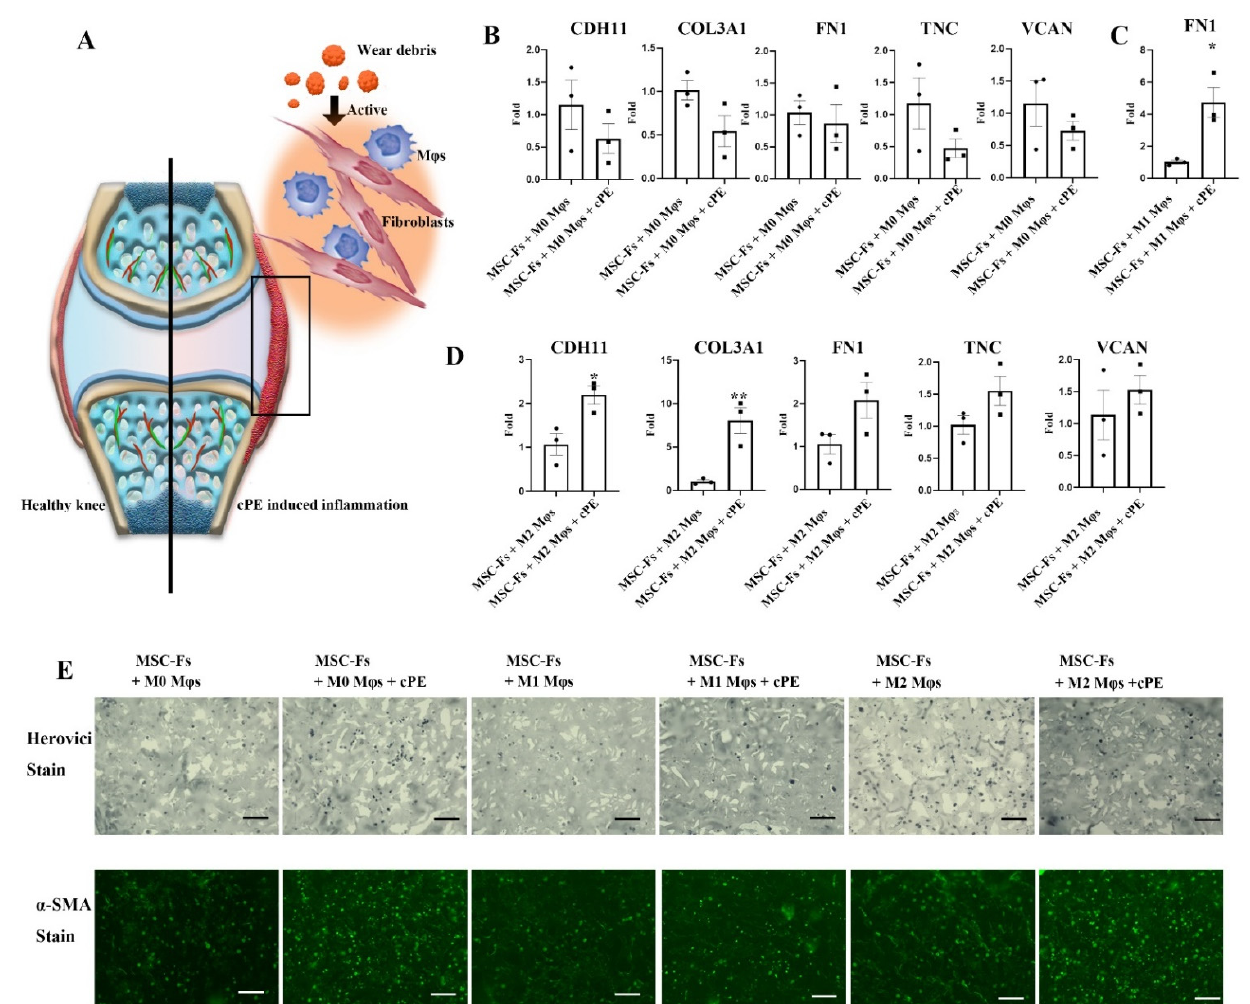
Figure 2. The effect of M ϕ s on the modulation of fibroblast functions in the presence of cPE. ( A ) Illustration of a synovial joint. Wear debris released after joint arthroplasty activates M ϕ s and fibroblasts in the synovial membrane. ( B ) Comparison of levels of fibroblast marker genes in the MSC-Fs and M0 M ϕ co-culture system, ( C ) MSC-Fs and M1 M ϕ co-culture system, and ( D ) MSC-Fs and M2 M ϕ co-culture system, with and without the presence of cPE (* p < 0.05, ** p < 0.01) (values are ±SEM). ( E ) Herovici staining to visualize collagen and α -SMA immunofluorescence staining (scale bar, 100 µm). Naïve (M0) M φ s respond to local stimulation and are polarized to either M1 M φ s,